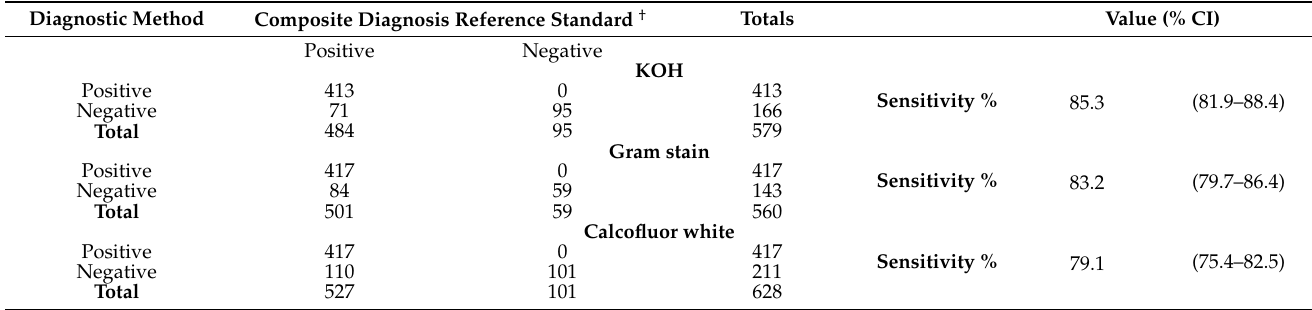
Table 3. Sensitivity values for detecting filamentous fungal keratitis ( n = 532) using different smear microscopy stains compared to a composite diagnosis reference standard (mixed infections included). The number of positive and negative test results is shown on the left. The sensitivity values are shown on the right.